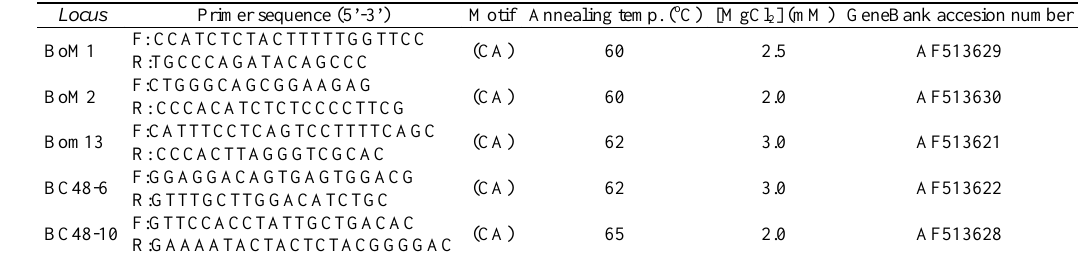
Table 2. Primer sequence, microsatellite motif, conditions for amplification and accession number on Genebank used for microsatellite genotyping of Brycon insignis